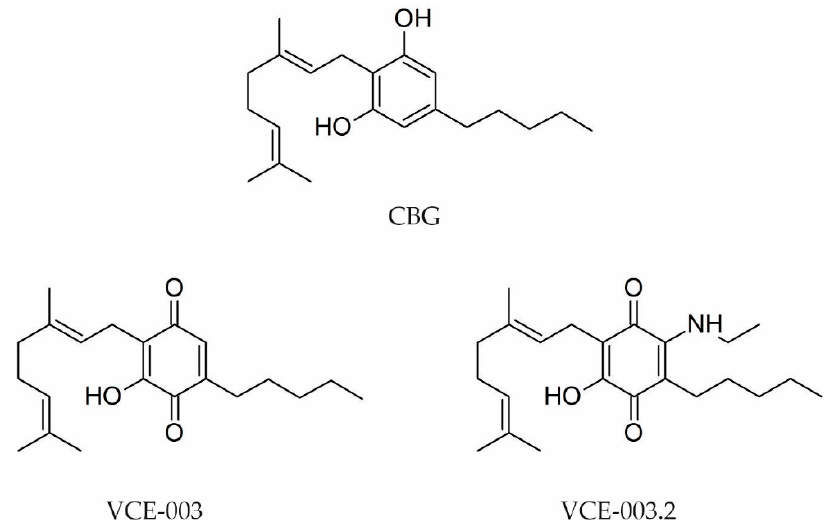
Figure 2. Chemical structures of CBG derivatives VCE ‐ 003 and VCE ‐ 003.2.